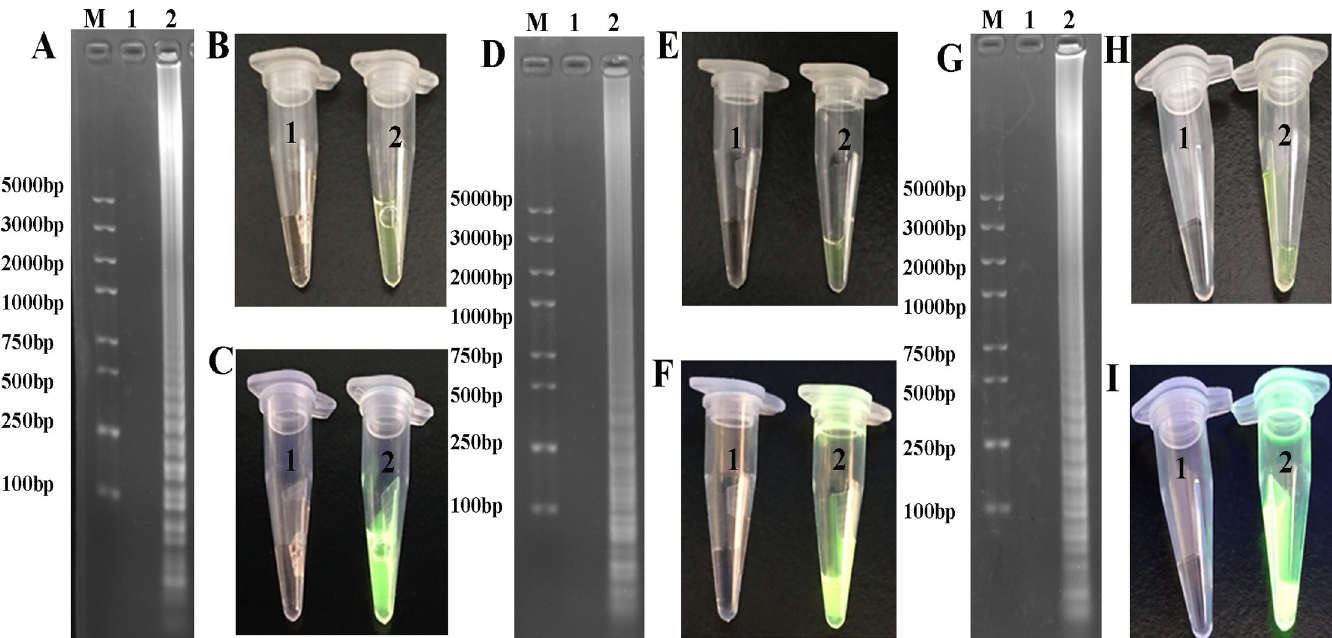
Fig 4. LAMP, CPA and IMSA amplification results. M, Trans 2K plus II DNA marker; 1, negative control; 2, Positive control. A, D and G, Agarose gel electrophoresis observation for LAMP, CPA and IMSA methods for LT-II gene. B, E and H, LAMP, CPA and IMSA reactions were observed upon addition of SYBR Green I, respectively. C, F and I, LAMP, CPA and IMSA reactions were visualized under UV light upon addition of SYBR Green I, respectively.